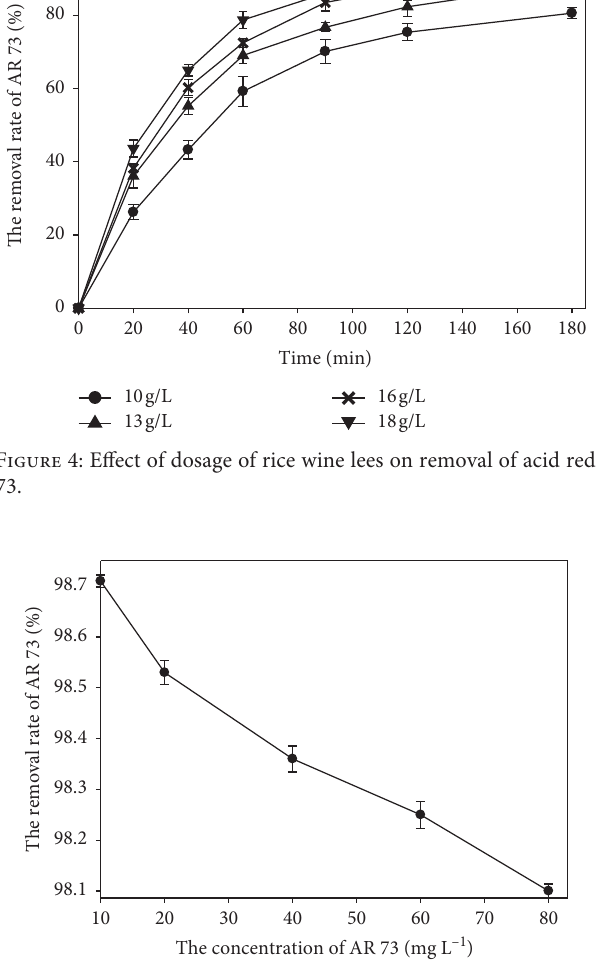
Figure 5: Removal rate of acid red 73 by rice wine lees after 20 hours.